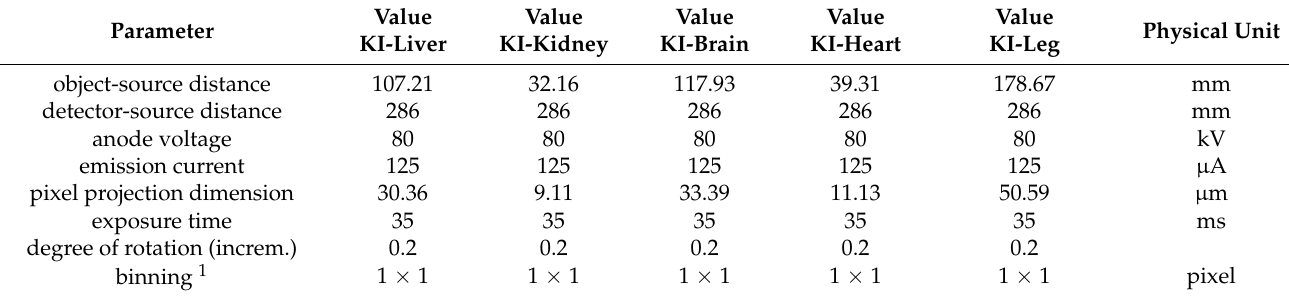
Table A19. Values of set parameters on SkyScan